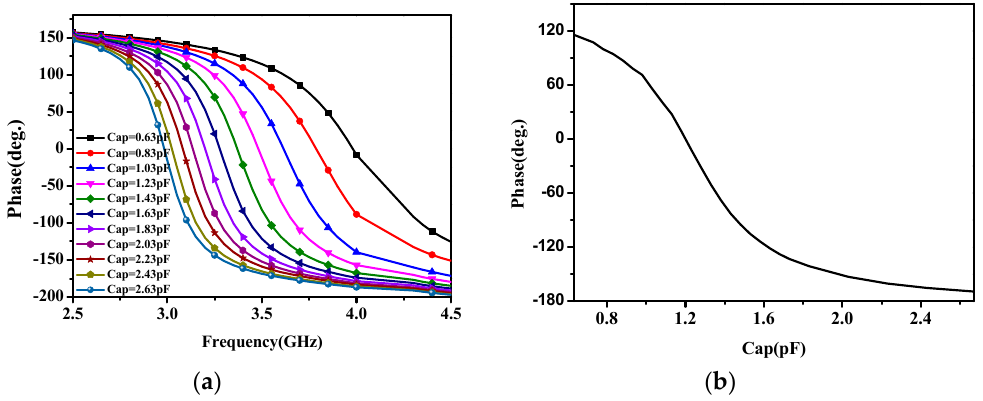
Figure 5. Reflection phase characteristics versus frequencies ( a ) With different capacitance; ( b ) At 3.5 GHz.